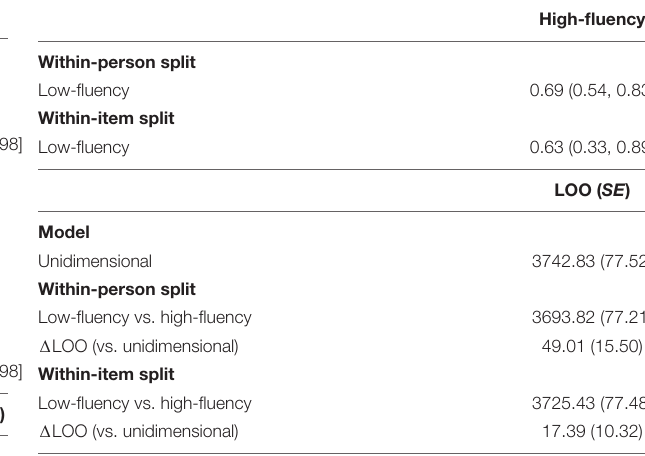
TABLE 1 | Comparison of unidimensional models vs. multidimensional models with respect to the nodes for the full model and for the be-creative instruction and be-fluent instruction.